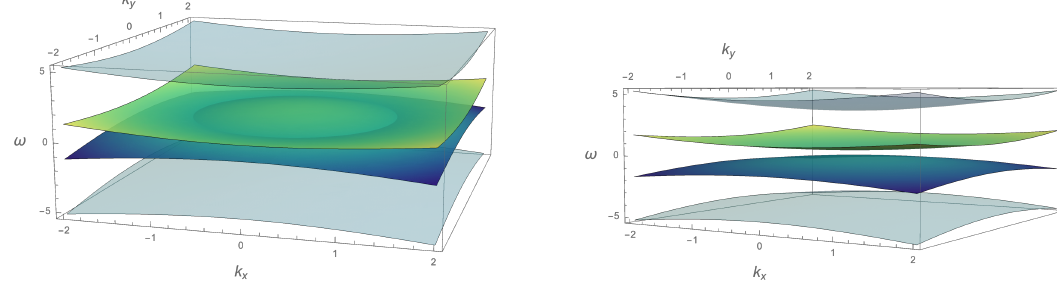
Figure 1 . The illustration of the band structures with k z = 0 for the nodal line semimetal phase (left) and the gapped phase (right). In the nodal line semimetal phase, the crossing band forms a nodal circle where the excitations can be described by the Weyl fermions. There is no band crossing at any nonzero k z